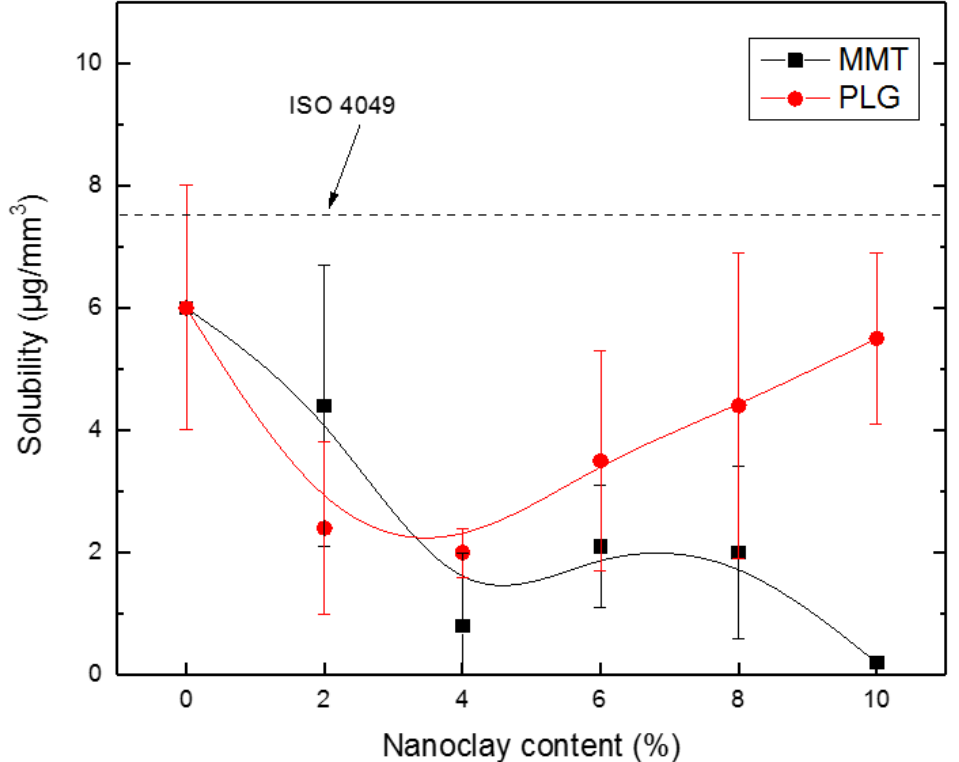
Figure 7. Solubility of dental composites prepared with either MMT or PLG at several concentrations.